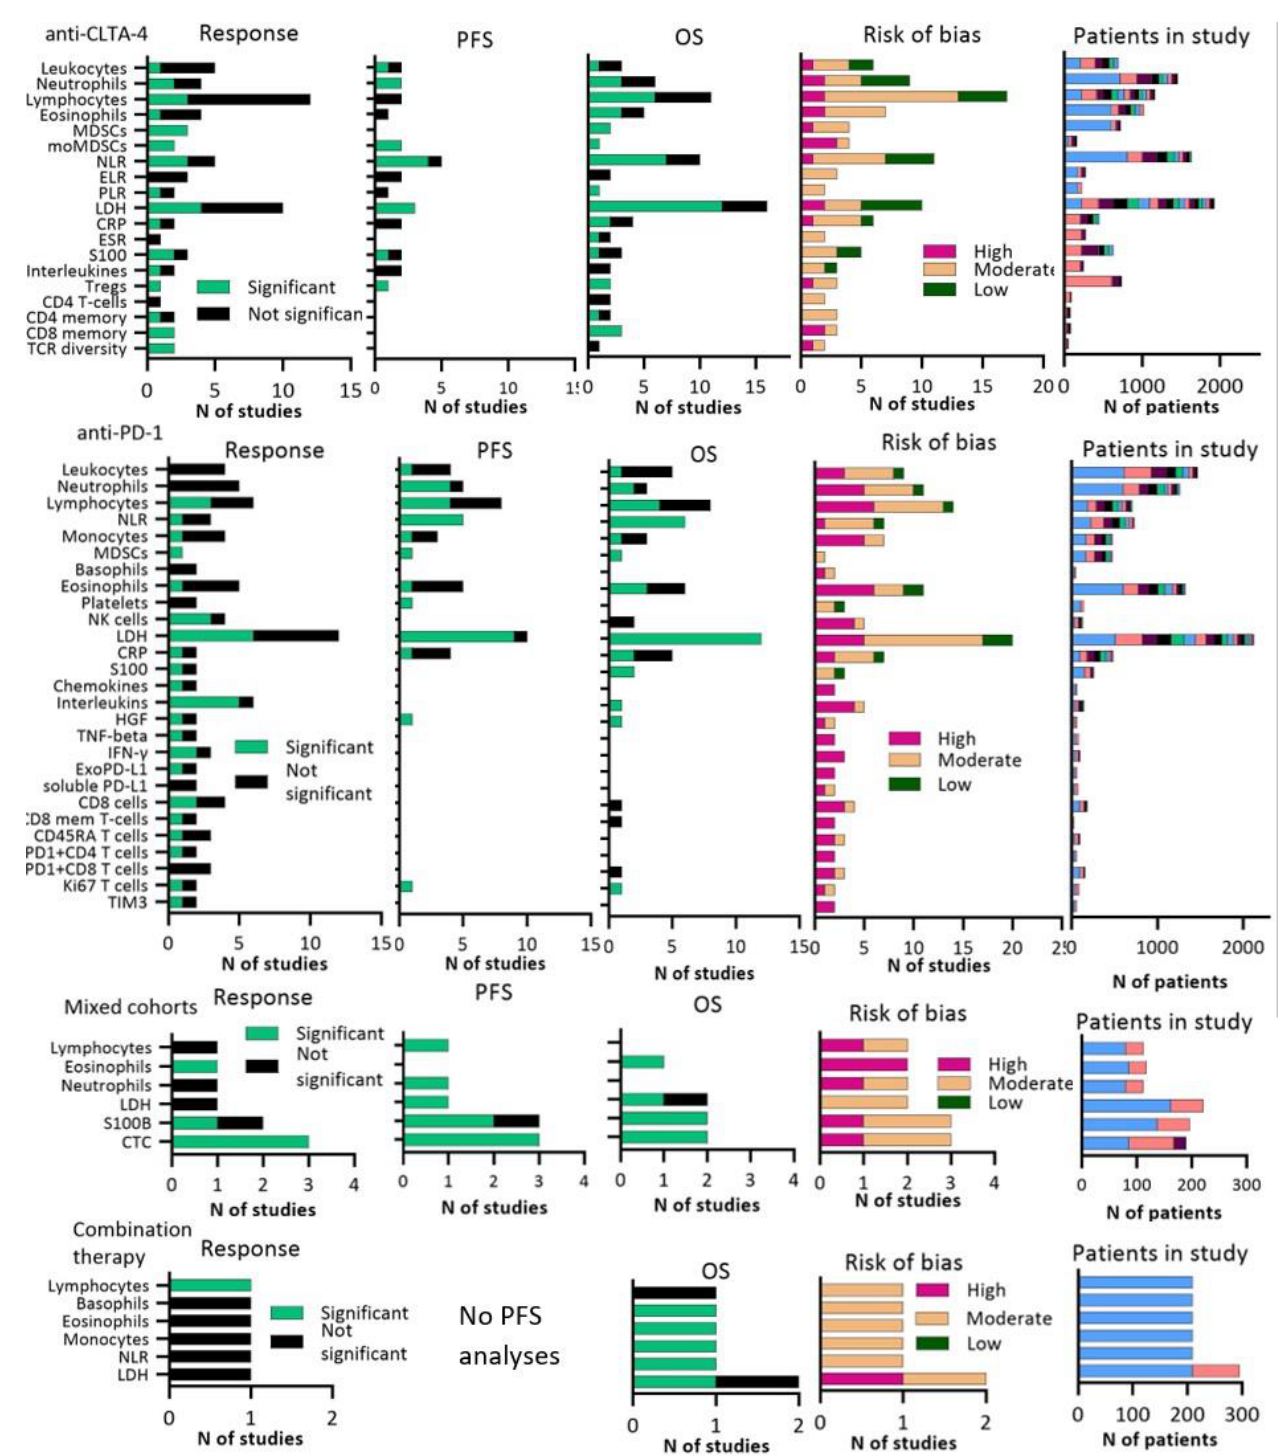
Figure 2. Graphs showing number of studies that were significantly associated or not associated to response, PFS, OS plus risk of bias per article for blood biomarkers. Right part of figure shows total number of included patients. A significant response was defined as p ≤ 0.05. Abbreviations; CRP:C-reactive Protein, CTC: circulating tumor cells, ELR: eosinophil-to- lymphocyte ratio, ESR: erythrocyte sedimentation ratio, HGF: hepatocyte growth factor, LDH: lactate dehydrogenase, NLR: neutrophil-to-lymphocyte ratio, PLR: platelet-to-lymphocyte ratio, Tregs: regulatory T-cells. Neutrophil-to-lymphocyte ratio (NLR) was investigated in 2605 patients and high NLR correlated with poor PFS in 9/10 studies and poor OS in 14/17 studies, whereas a studied NLR was the study of Ferrucci and colleagues [19]. In 720 melanoma patients treated with ipilimumab, they found that an elevated NLR at baseline was associated with